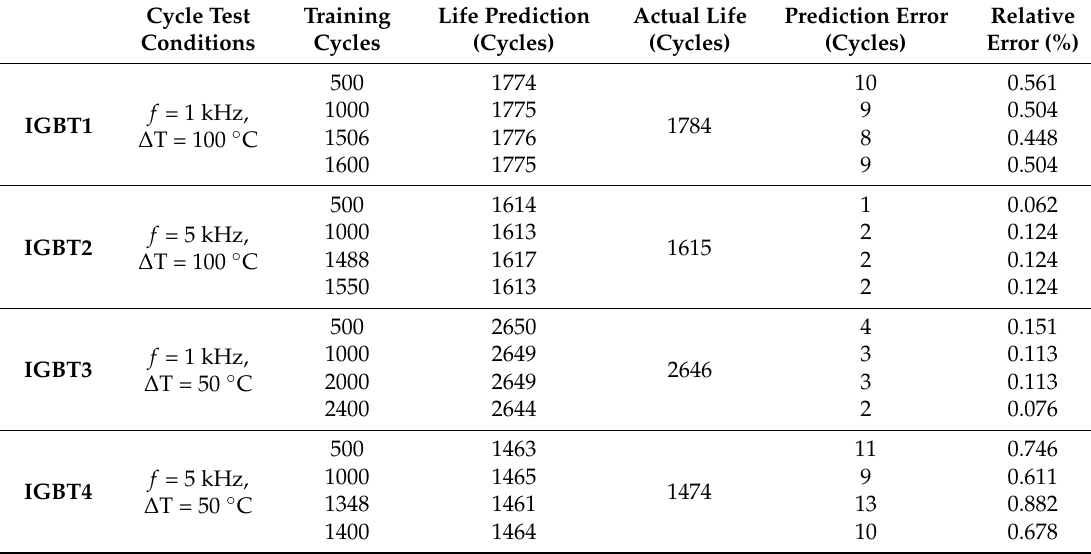
Table 6. The Life prediction error result foreach IGBT experimental dataset at different training cycles